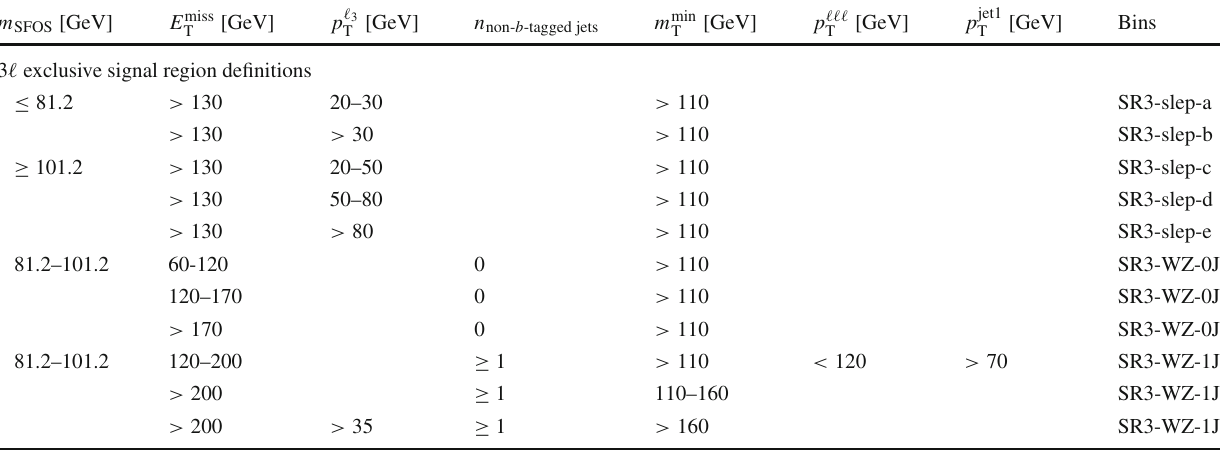
Table 3 Summary of the exclusive signal regions used in the 3 (cid:4) channel. Relevant kinematic variables are defined in the text. The bins labelled “slep” target slepton-mediated decays whereas those labelled “WZ” target gauge-boson-mediated decays. The variable